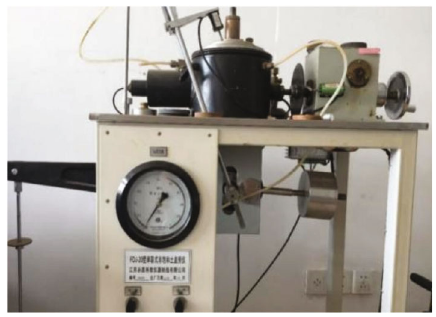
Figure 2: FDJ-20 direct shear